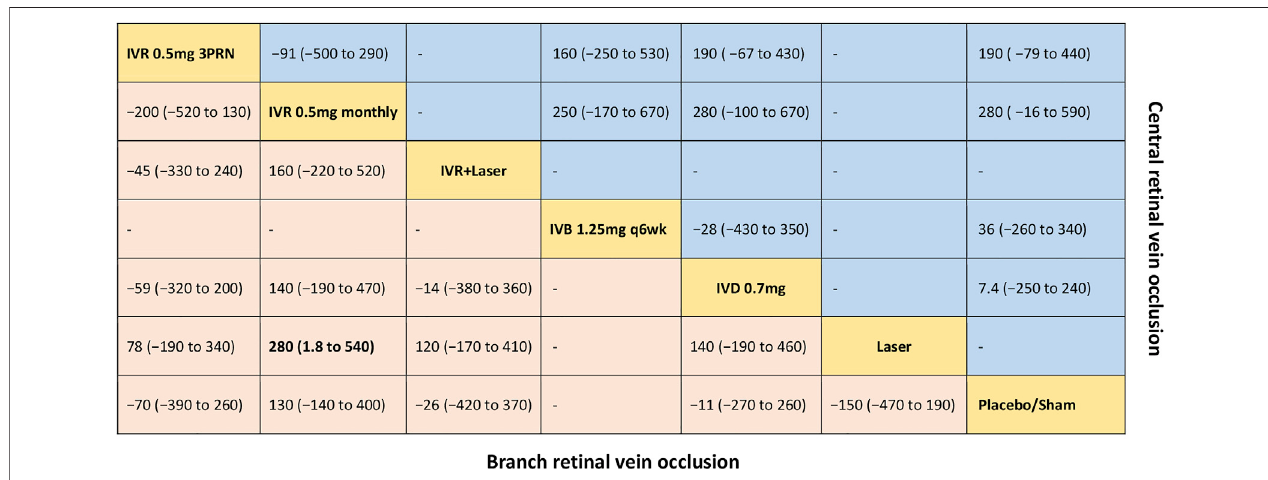
FIGURE 4 | Comparative effectiveness of pharmacotherapies in term of the mean change in central retinal thickness for macular edema secondary to retinal vein occlusioninnetworkmeta-analysis.Weightedmeandifference(95%credibleinterval)forcomparisonsareincellsincommonbetweencolumn-de fi ningandrow-de fi ning treatment. Bold cells are signi fi cant. For branch retinal vein occlusion, weighted mean difference < 0 favors row-de fi ning treatment. For central retinal vein occlusion, weighted mean difference < 0 favors column-de fi ning